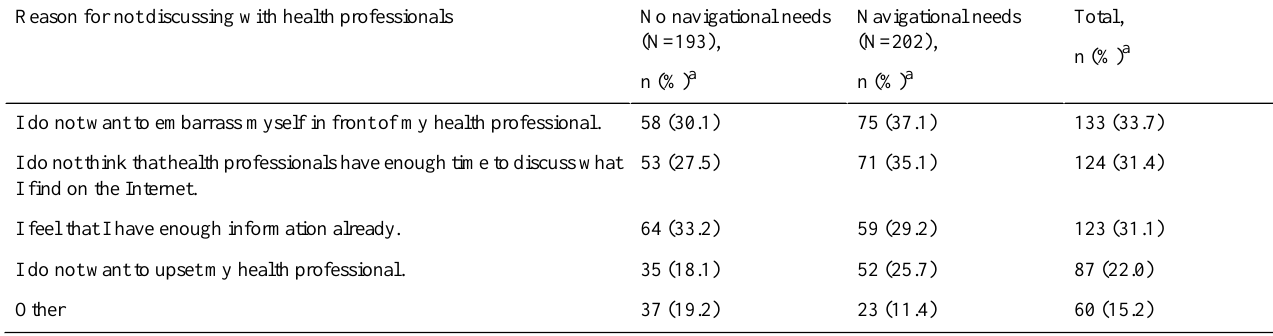
Table 4. Reasons why health information obtained from the Internet may not be discussed with health professionals (N=395).